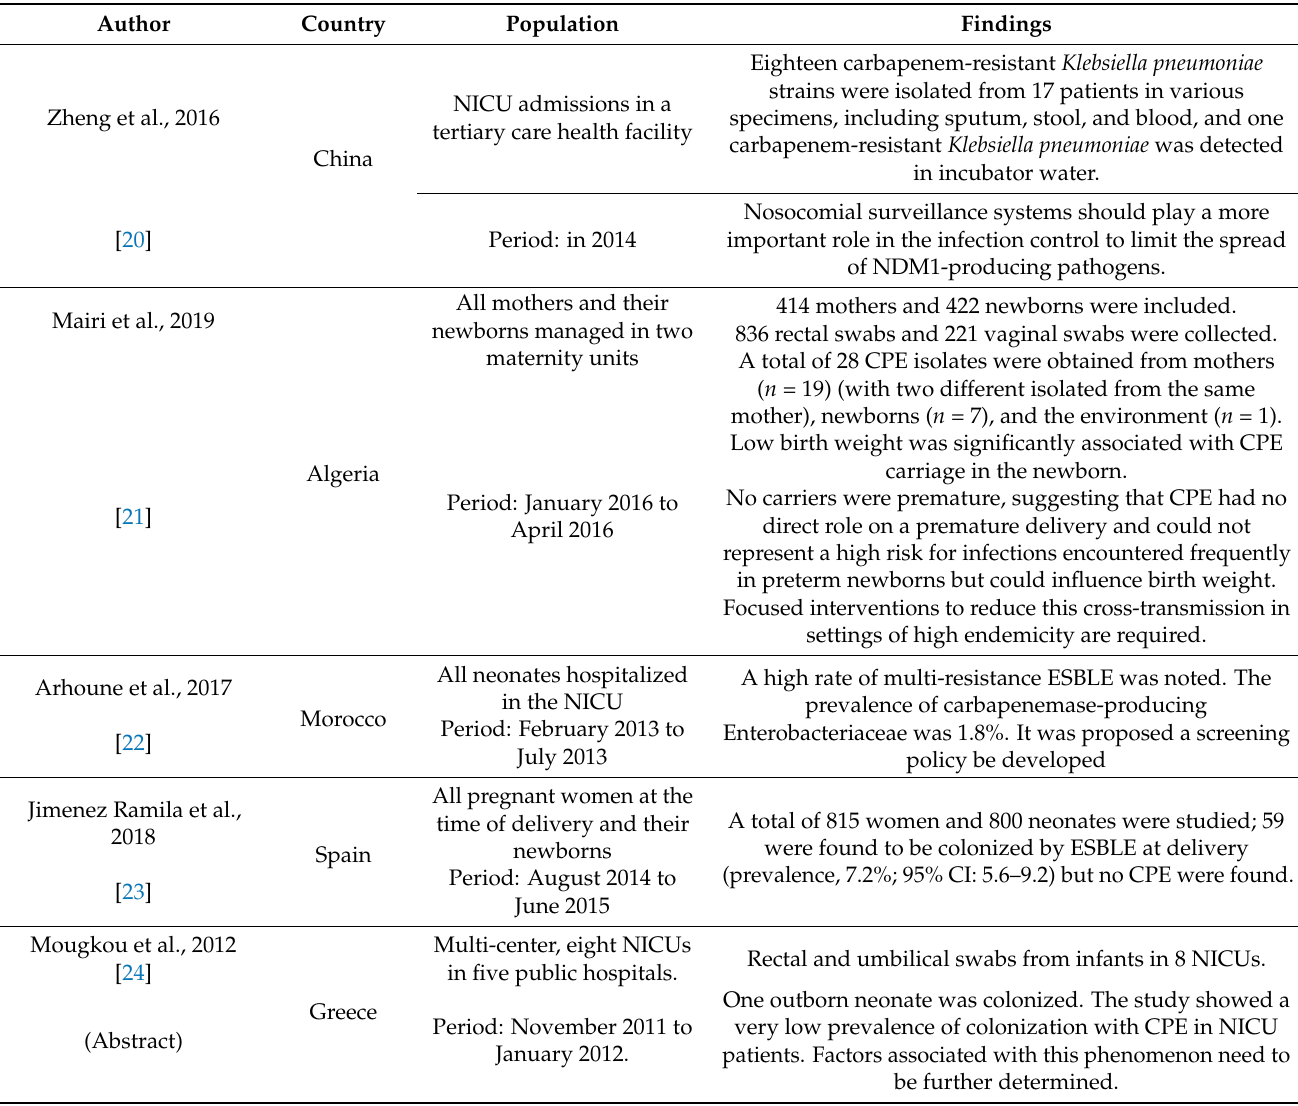
Table 2. Published findings of CP-CRE in